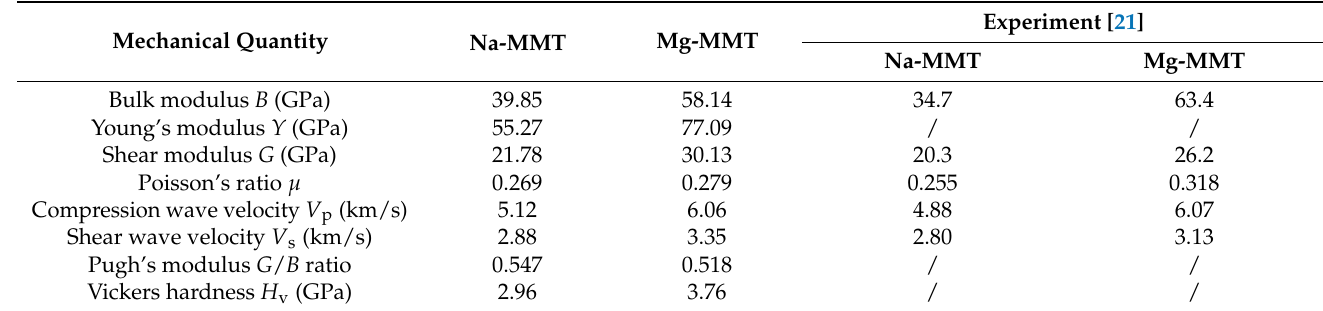
Table 7. The calculated bulk modulus ( B ), shear modulus ( G ), Young’s modulus ( Y ), Poisson’s ratio ( µ ), Pugh’s modulus ( G / B ), Vicker’s hardness ( H v ), compression wave velocity ( V p ), and shear wave velocity ( V s ) of the Na-MMT and Mg-MMT compared with experimental data. / means that the relevant value is not given in Reference